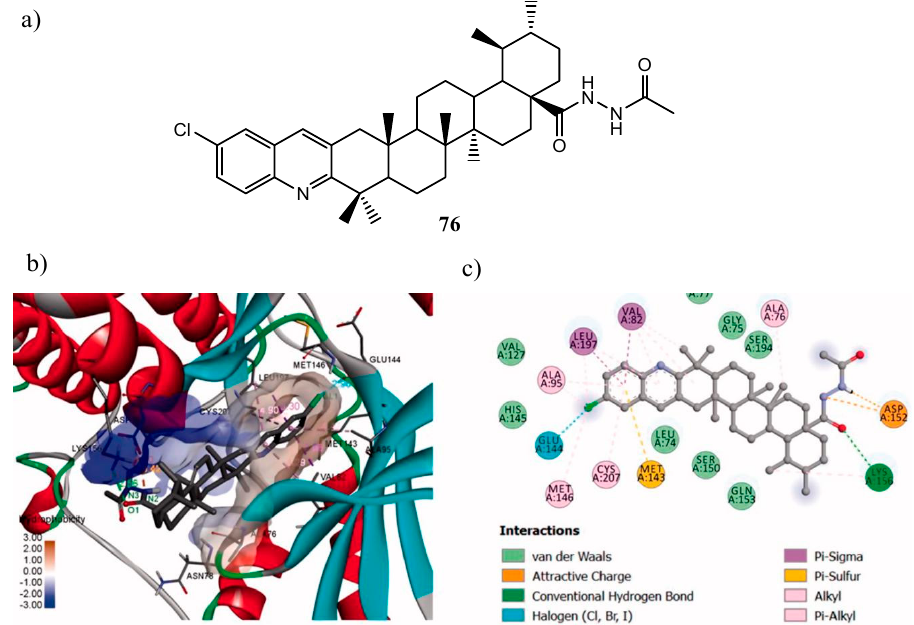
Figure 40. ( a ) structure of the quinoline derivative of ursolic acid 76 ; ( b ) binding pose of 76 within MEK1 kinase domain (PDB id: 3EQF); ( c ) ligand interactions of 76 docked into MEK1 active site [149].